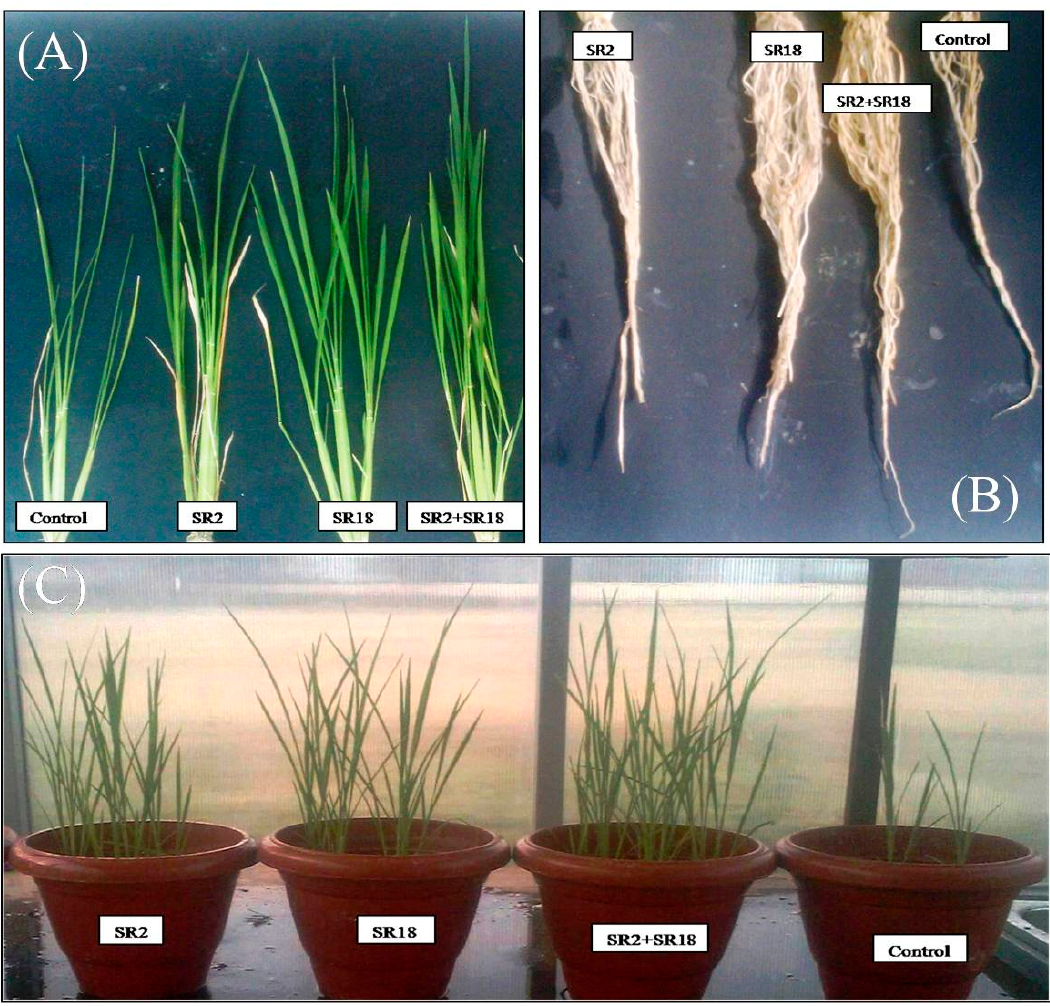
Figure 3. Effect of single inoculation and coinoculation of Bacillus strains on different growth parameters of rice plants ( A ) Comparison of shoot length of rice plants: control, SR2, SR18, SR2, and SR18 ( B ) Comparison of root length of rice plants ( C ) Comparison of overall plant growth promotion of rice plants. Table 4. Effect of single inoculation and coinoculation of Bacillus strains on different growth pa ‐ rameters of rice plants under greenhouse conditions.